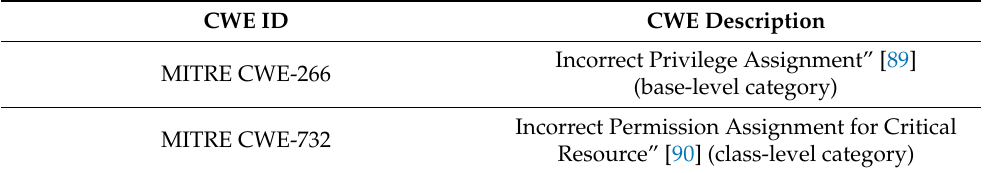
Table 7. Broken Access